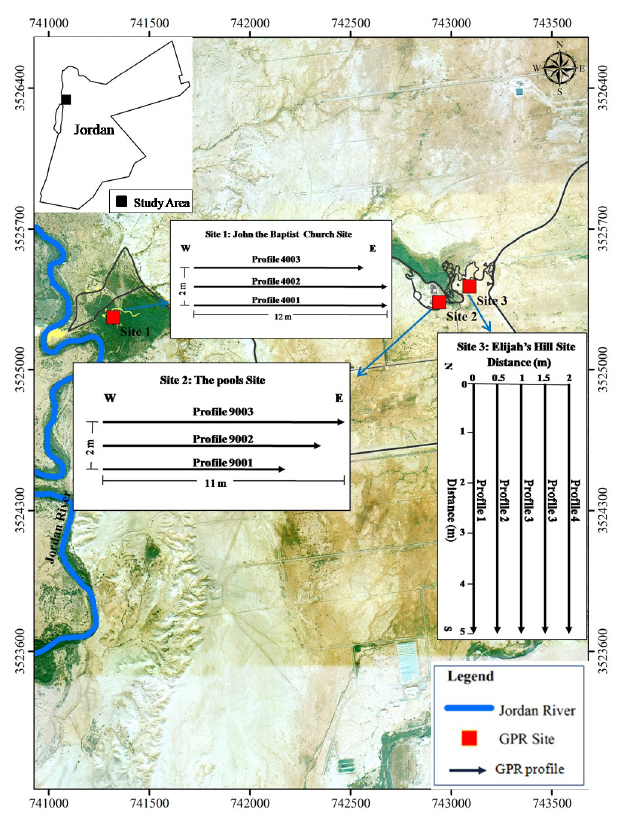
Figure 1. Location map of the GPR profiles study area “After © Google